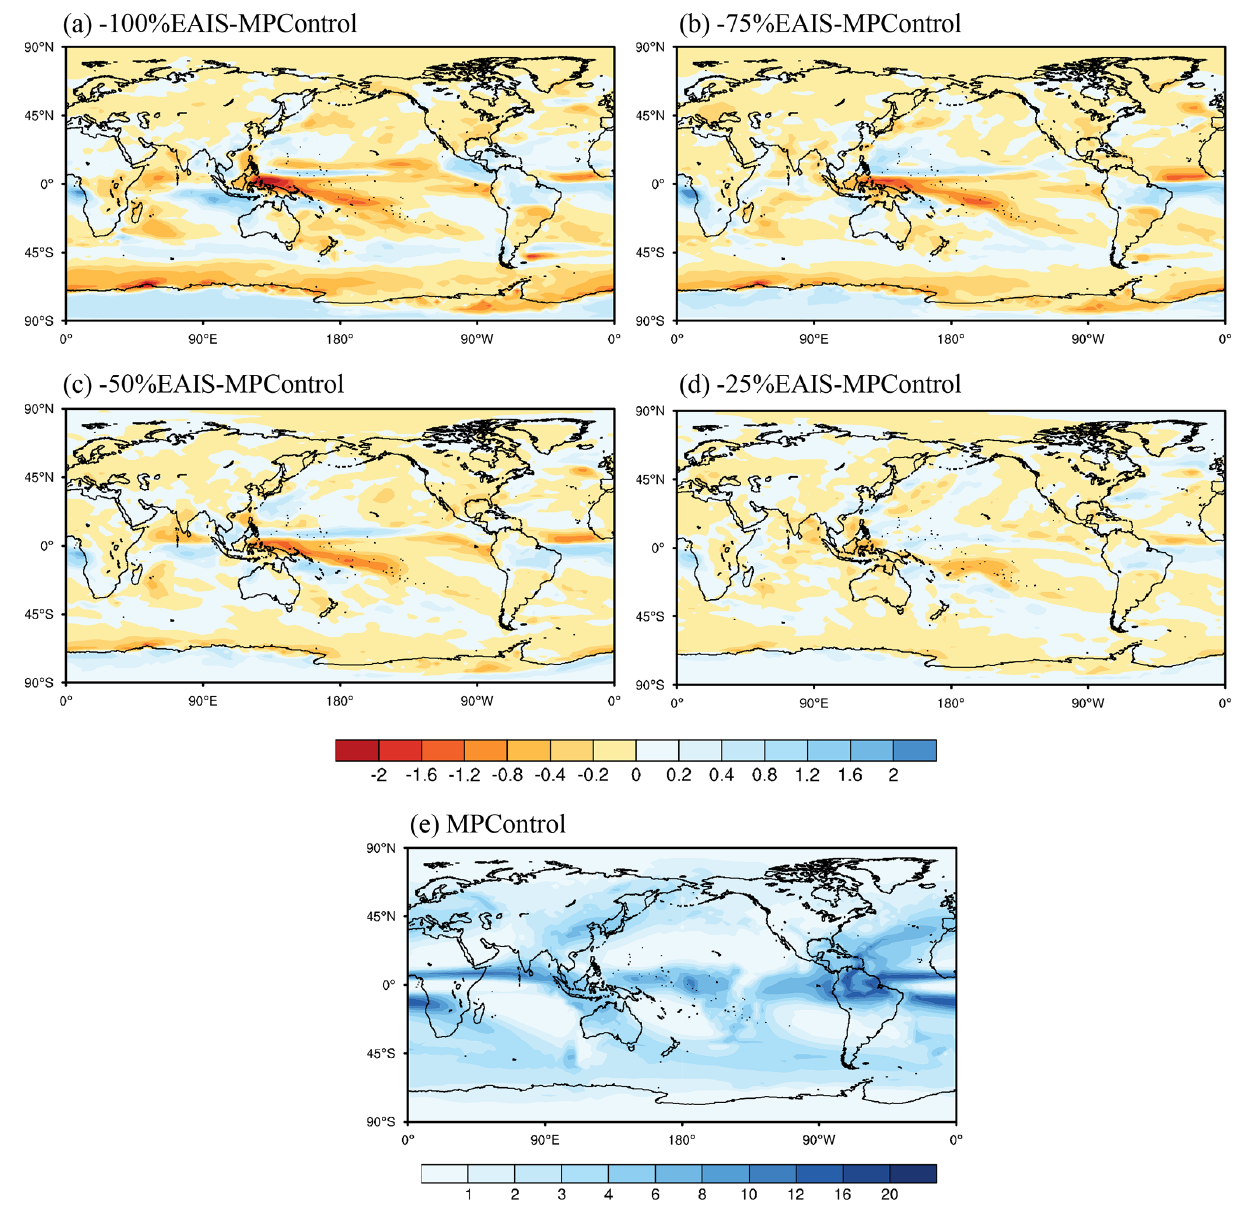
Figure 5. Spatial distribution of the annual mean precipitation anomalies (units: mmd − 1 ) between sensitivity experiments and MPControl experiments (a–d) , and spatial distribution of the annual mean precipitation for the MPControl experiments (e)